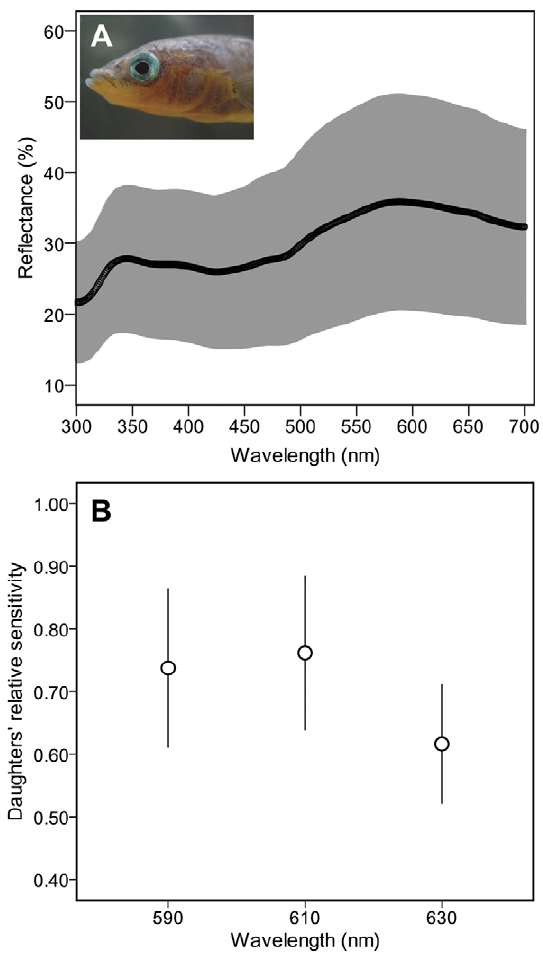
Figure 3. Comparison between red color expression in fathers and the red sensitivity of their daughters (n=25). Relationship between daughters’ relative sensitivity at 590 nm and fathers’ (A) red chroma (after negative reciprocal transformation) and (B) chromaticity, respectively. The lines are the least square regressions [(A): Y =0.413x + 1.897, R 2 =0.547, F =27.80, P , 0.0001; (B): Y =3.997x 2 0.211, R 2 =0.373, F =13.70, P , 0.01].